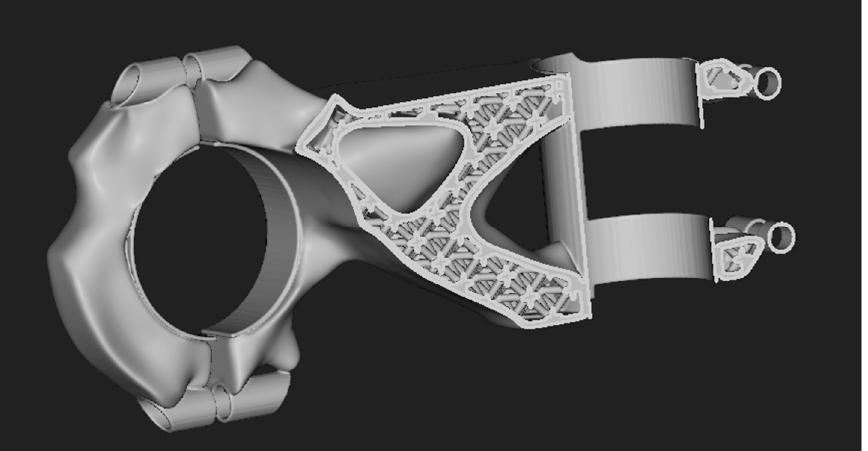
Figure 8. Section view of the result of the redesign using lattice-type tools with Ntop platform software.